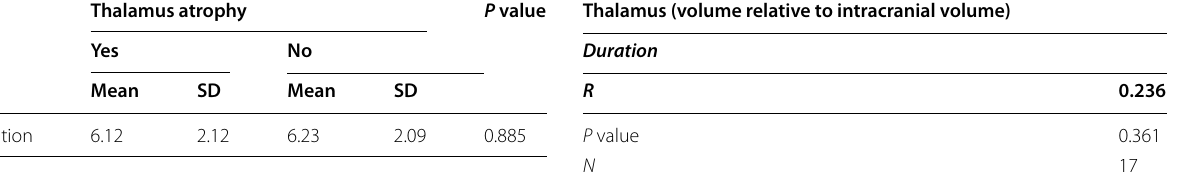
Table 14 Relation between duration of illness and degree of volume loss of thalamus in patients with thalamic atrophy